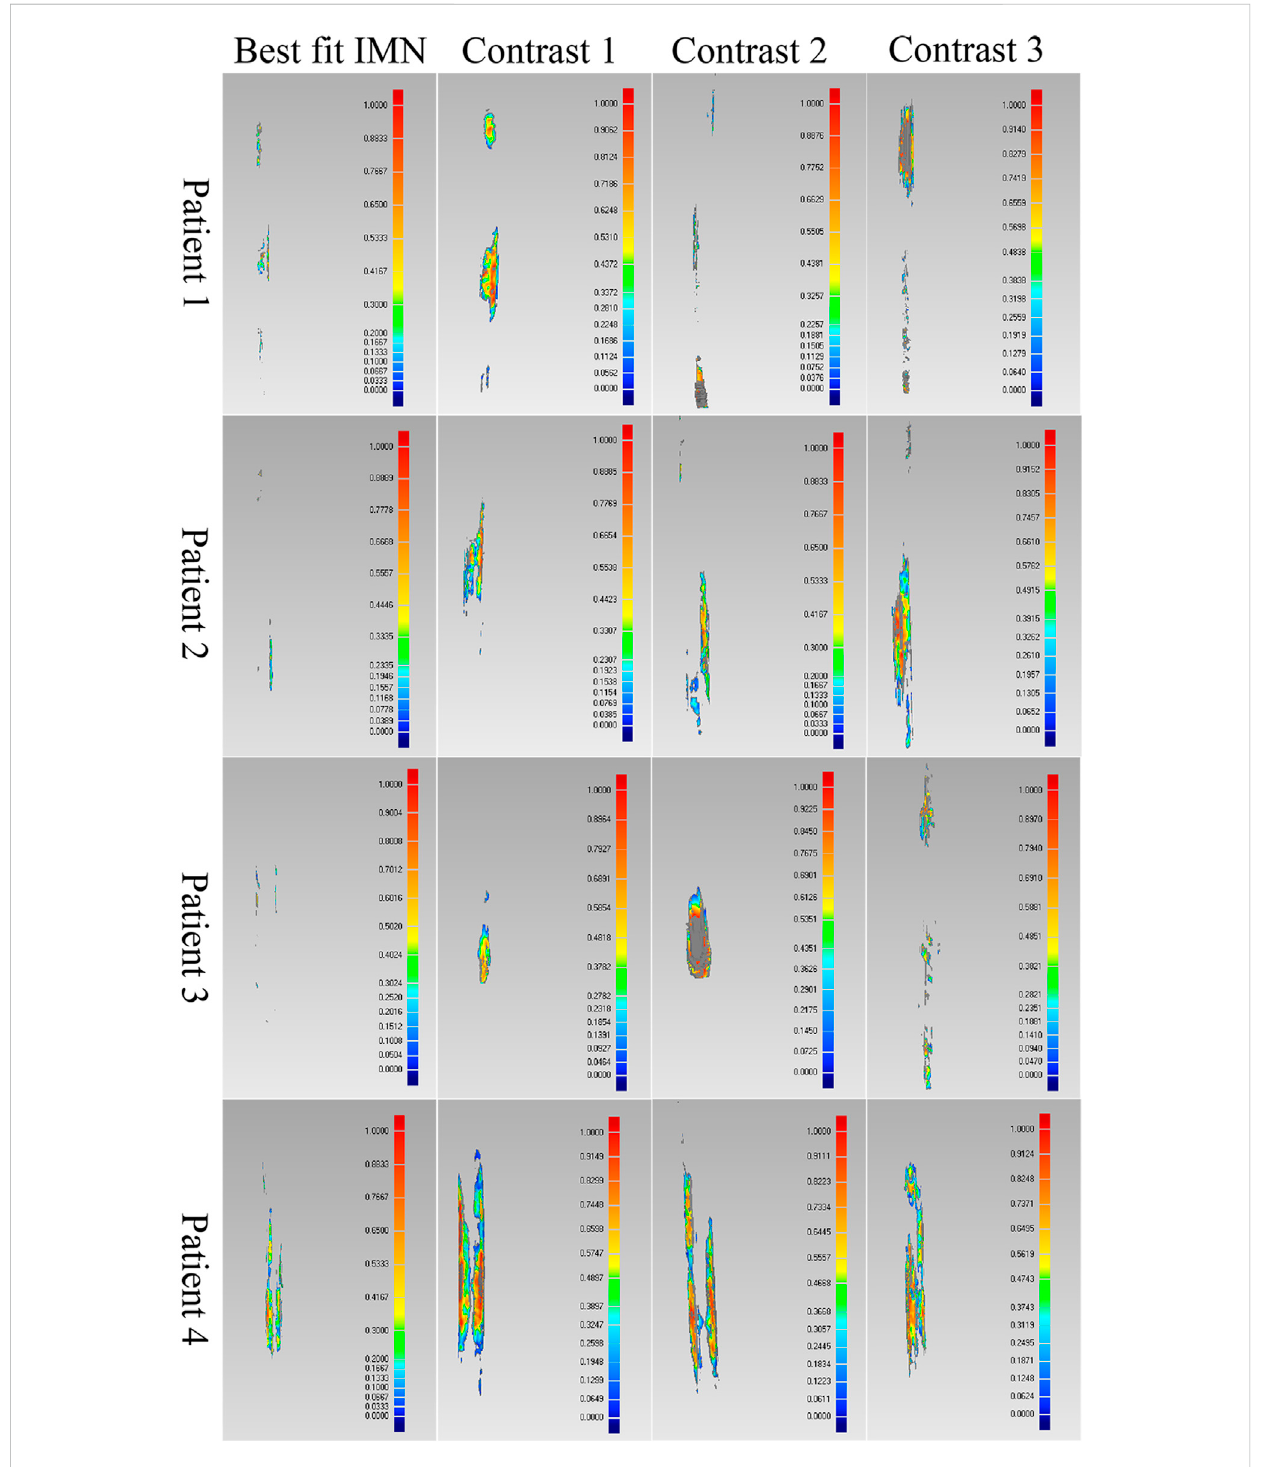
FIGURE 8 Comparison results of the optimal intramedullary nails for four patients. Different colors represent different wall thickness, the thickness increases gradually from blue to red, the maximum thickness is 1 mm, and gray indicates that the wall thickness here exceeds 1 mm.